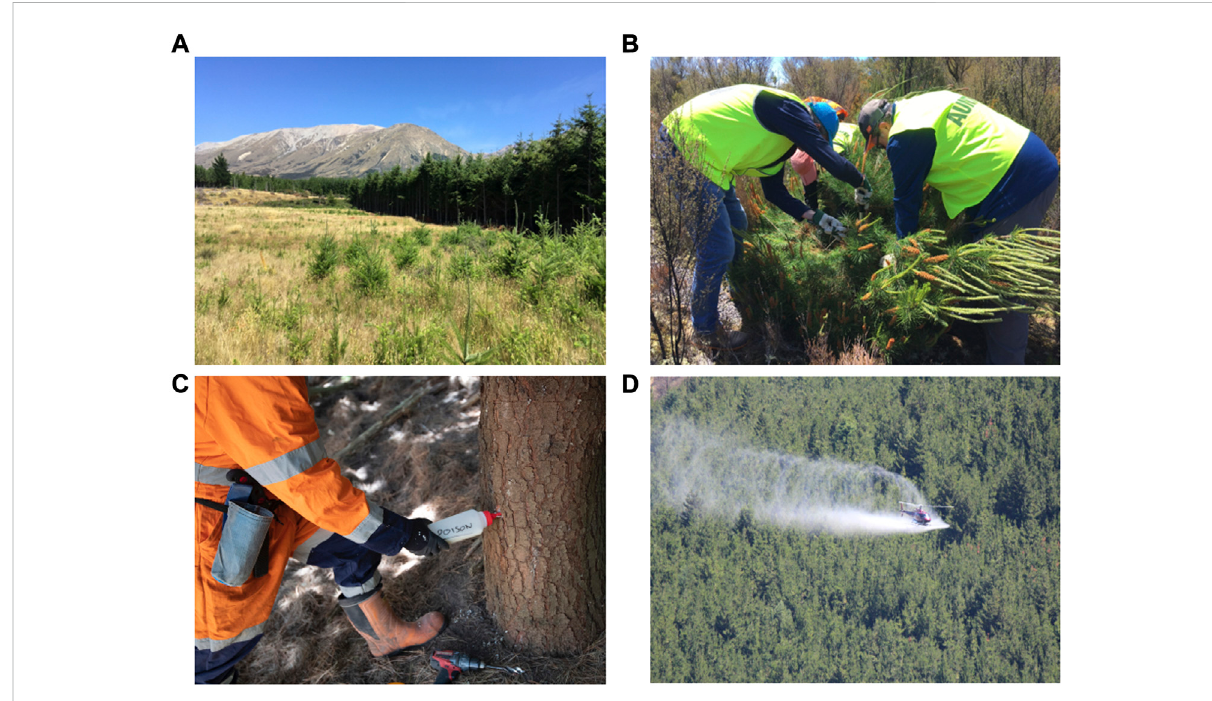
FIGURE 3 Illustrative examples of how research, management and communities adapt as conifer invasions proceed: (A) early invasion from a nearby plantation, demonstrating the need for prevention and early control; (B) a community workday in which volunteers tackle local invasions of small- sized trees; (C) acontractor inaction, controlling a moderate density invasion; (D) large-scale management, in which helicoptersare used to aerially sprayherbicidesondenseinvasions.Photosinpanels (A) and (B) credittoRowanSprague.Photoinpanel (C) credittoBiosecurityNewZealand. Photo in panel (D) credit to Nick